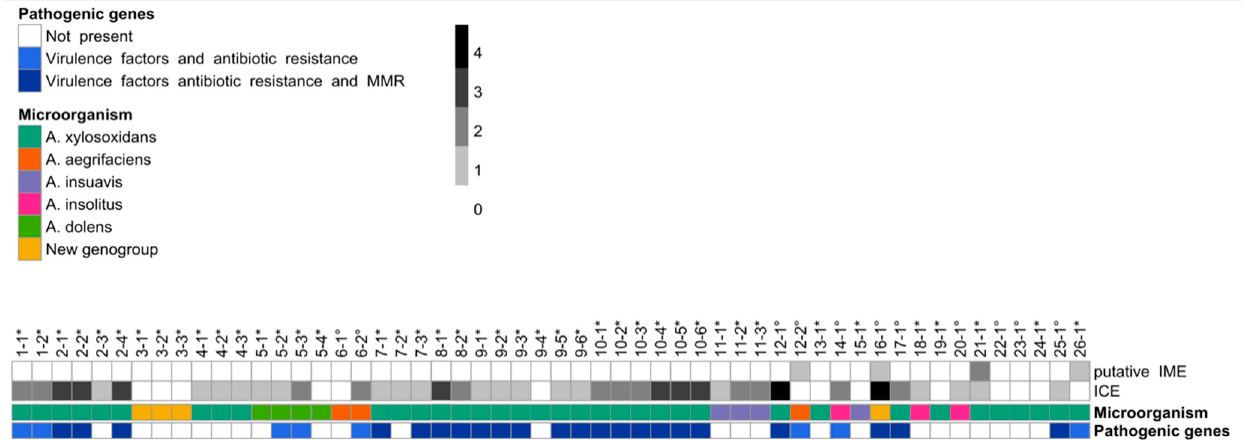
Figure 3. Integrative and conjugative elements (ICEs) and integrative and mobilizable elements (IMEs) analysis. The heatmap shows the presence and number (grey scale) of ICEs and IMEs. The columns represent patients and isolates identification numbers. * indicates chronic infection isolates; ° indicates occasional infection isolates. Additional information regarding the microorganism species and pathogenic genes carried by mobile elements is represented in the annotation row (color scale) at the bottom.